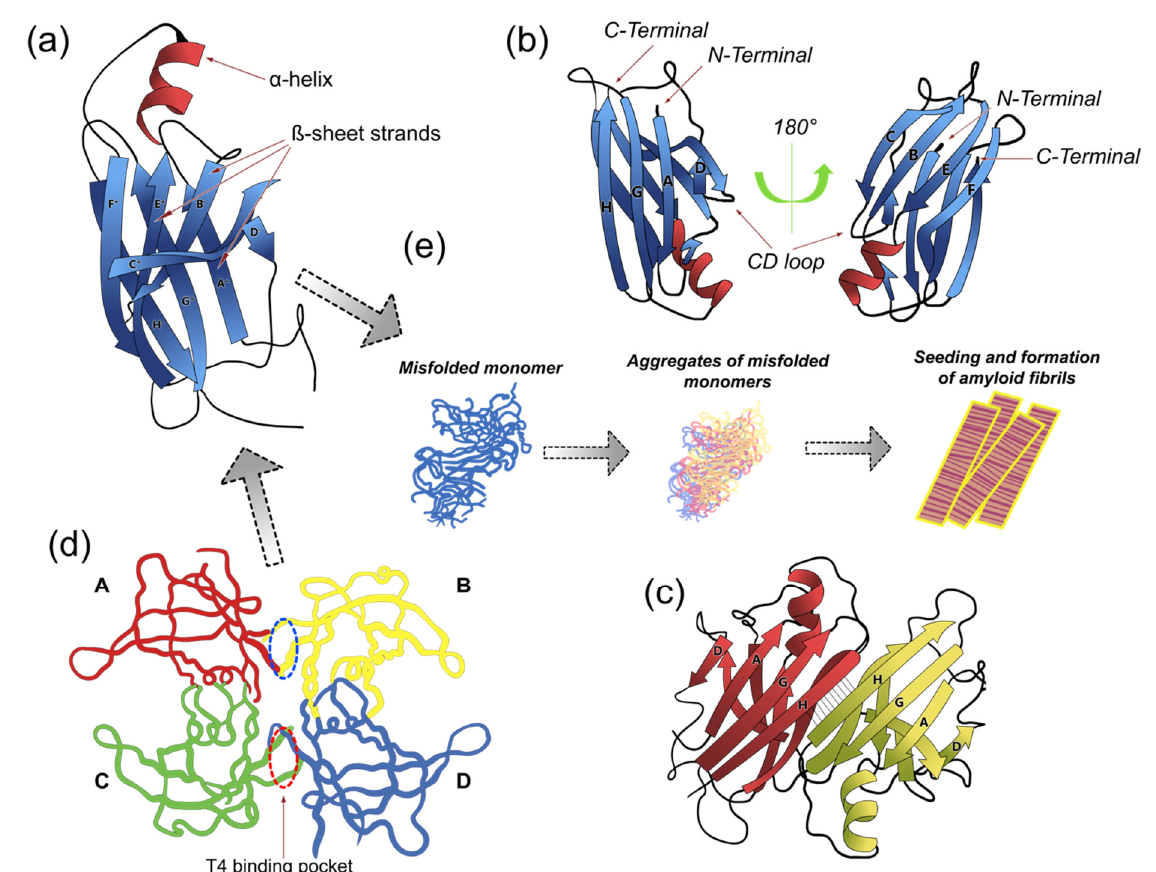
Figure 1. Transthyretin (TTR) conformational structures. TTR is a homotetrameric protein composed of four monomers of 127 amino acids each. Each monomer contains one small α -helix and eight β -strands (CBEF and DAGH) ( a , b ), which are arranged in a β -sandwich of two four-stranded β -sheets and one small α -helix found between β -strands E and F. TTR monomers interact via hydrogen bonds between the antiparallel, adjacent β -strands H-H’ and F-F’ to form a dimeric species ( c ). The two dimers (A-B and C-D) form the tetramer through hydrophobic contacts between the residues of the A and B, and G and H loops. The tetramer forms a central hydrophobic pocket (T4 channel) with two binding sites for hormones (red and blue ovals in ( d )). ( e ) The TTR tetramer dissociates into dimers and lowest free-energy monomers more prone to form fibrils; mutant monomers misfold, aggregate, and subsequently form prefibrillar compounds and amyloid fibrils. In this scenario, tetramer dissociation into monomers is the rate-liming step of the aggregation reaction. Based on this model, several studies have focused on developing effective and selective therapeutic approaches (i.e., TTR ligands) aimed to prevent TTR dissociation and aggregation. (Model adapted from PDB code 1DVQ